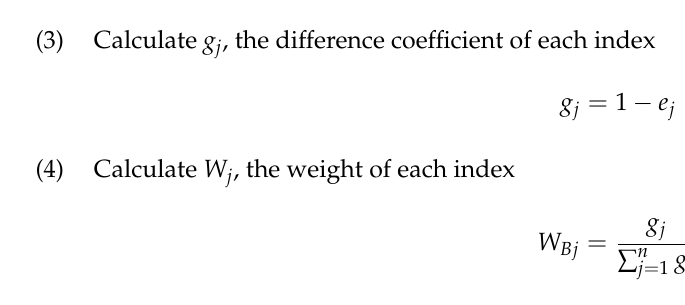
Figure 6. Value of commonality indexes of wind power generation (WG) in 20 regions. As can be seen from Figure 6, among the 20 regions, WG in region 2 has the highest economic benefits, however, whose social benefits, resource development and policy support are almost behind those in other regions. The social benefits and funding sources of WG in region 18 are in a leading position, however, the environmental benefits are the lowest, moreover, policy support is not satisfactory. 5.1.2. The Calculation of Weights of Commonality Indexes According to Equation (6), AHP is used to calculate the weights of benefits, resource development and development potential of the commonality indexes, so are the weights of their respective subindexes. The calculation results are shown in Table 10.